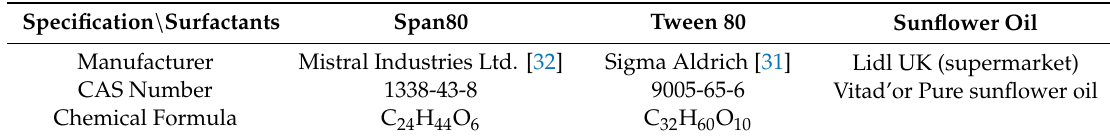
Table 2. Surfactant specifications.